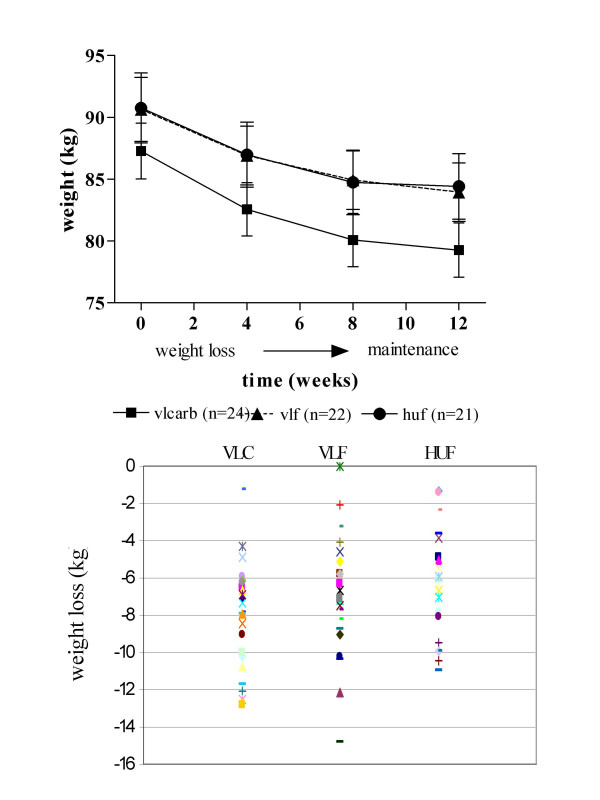
Weight loss according to dietary treatment1. 1mean ± SEM. VLCARB = very low carbohydrate diet (n = 24) VLF = very low fat diet (n = 22) HUF = high unsaturated fat (n = 21). There were no significant differences in absolute weight loss according to dietary treatment.